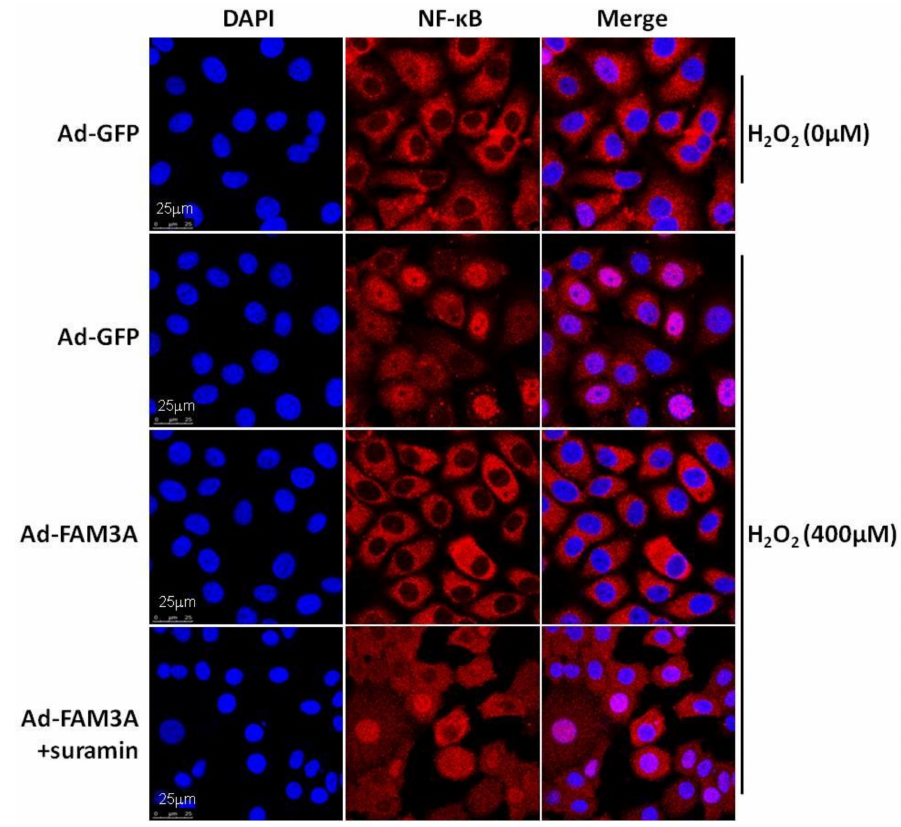
Figure 1. FAM3A inhibited NF- κ B activation induced by oxidative stress in HepG2 cells. Oxidative stress increased nuclear localization of NF- κ B, which was reversed by FAM3A overexpression. Moreover, FAM3A -induced inhibition of NF- κ B was partially reversed by P2 receptor antagonist suramin. The scale bar indicated in the images is 25 µ